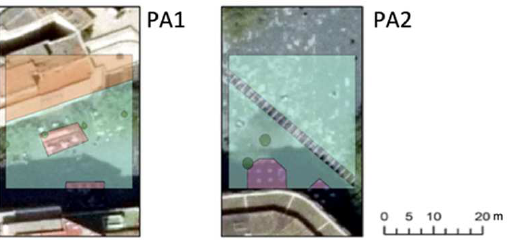
Figure 2. Example of two different calibrated areas in the same area of study in Palma. The LoSD indicator was obtained from the number of devices detected by Wi-Fi in- frastructure using Equation (2) as follows: